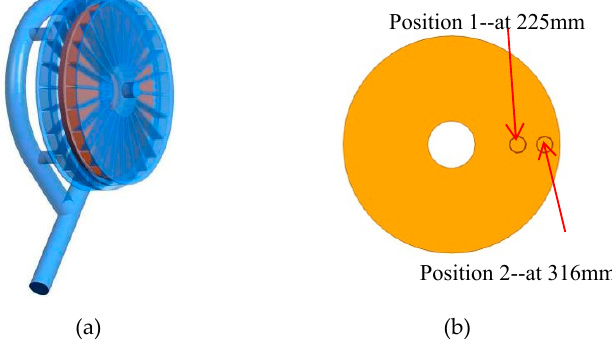
Figure 4. Solid structure of rotating disc: (a) Whole flow passage of rotating disc; (b) Surface of rotating disc.